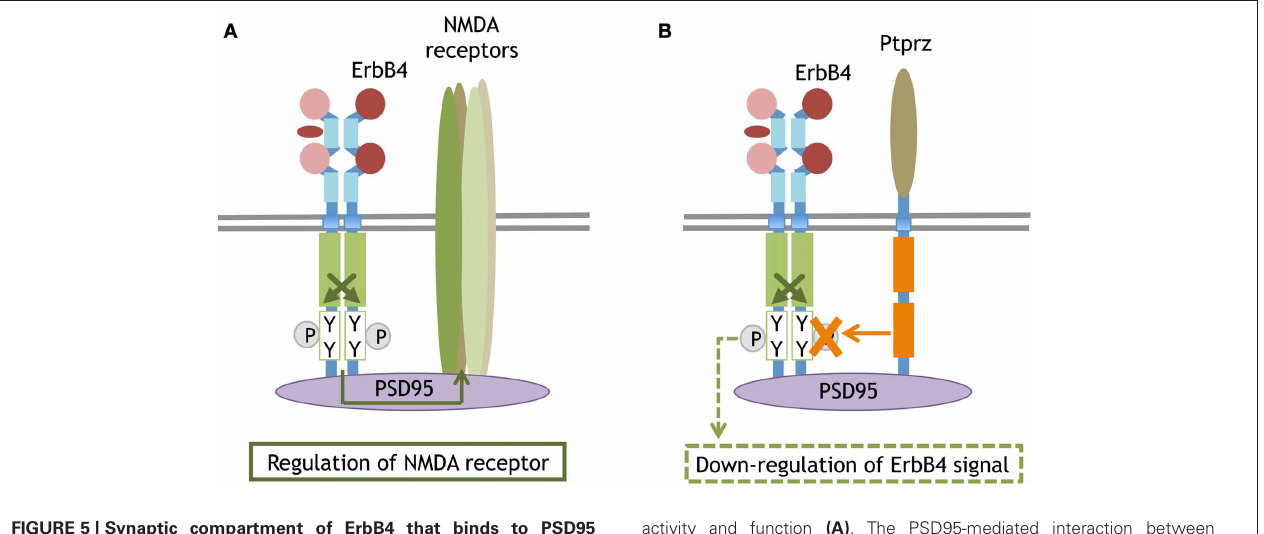
FIGURE 5 | Synaptic compartment of ErbB4 that binds to PSD95 or interacts with the phosphatase. The scaffolding protein PSD95 anchors ErbB4 and the NMDA receptor at postsynaptic sites. The molecular interaction between ErbB4 influences NMDA receptor